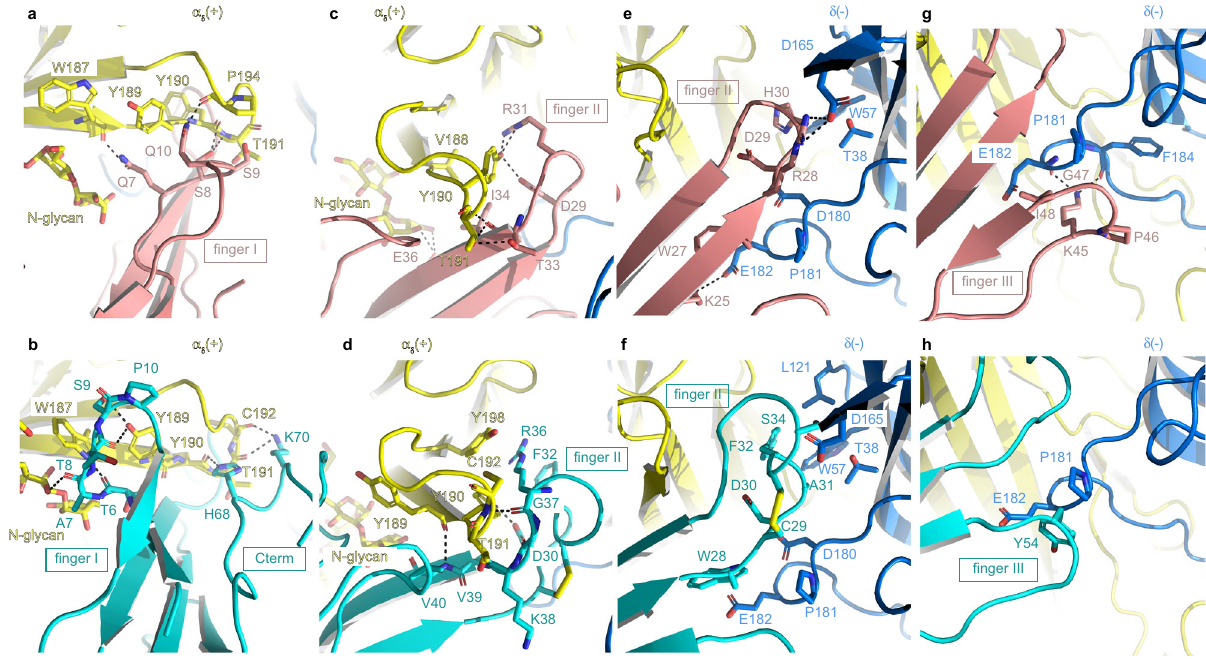
fi nger I of ScNtx and α -Bgtx. For α -Bgtx, additional interactions with the extended C-terminus are included. c , d Interactions between the principal subunit ( α δ ) and fi ngerIIofScNtx and α -Bgtx. e , f Interactions between the complementary subunit ( δ )and fi ngerIIofScNtxand α -Bgtx. g , h Interactionsbetweenthecomplementary subunit ( δ ) and fi nger III of ScNtx and α